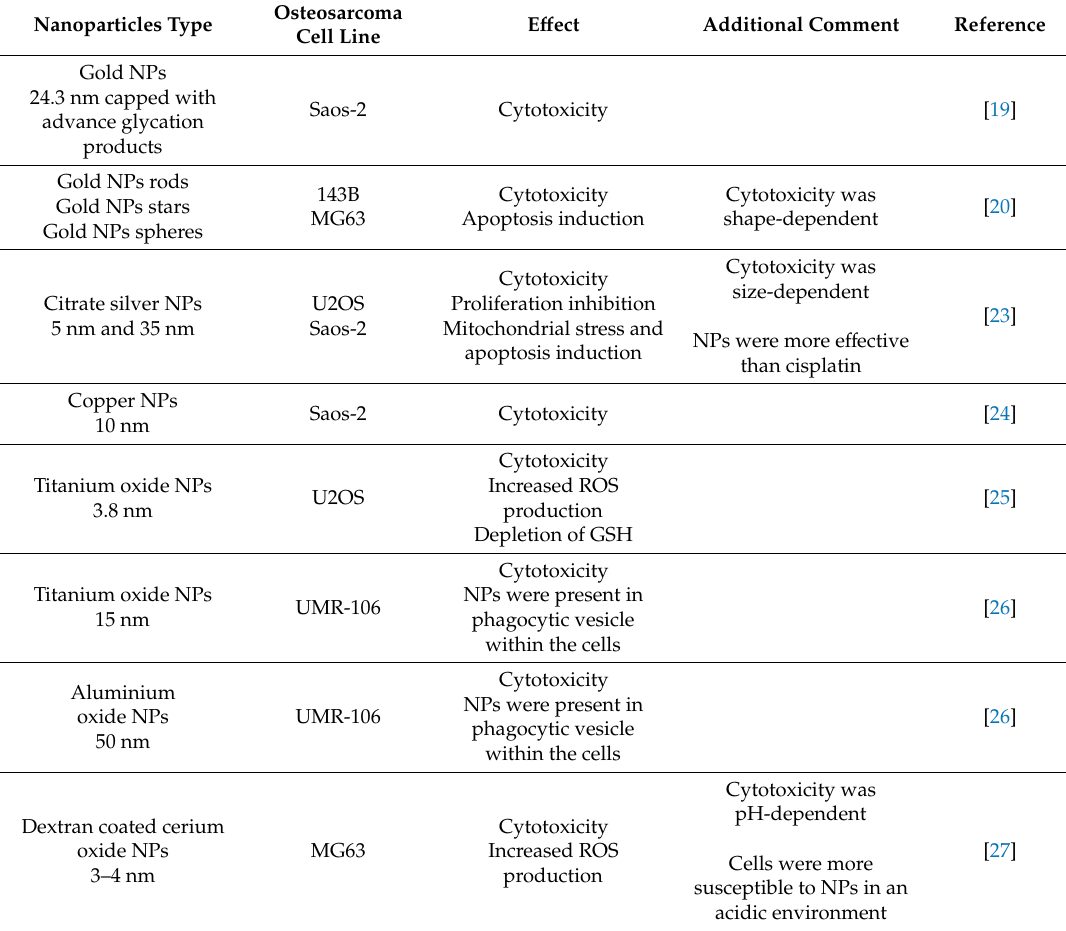
Table 1. Summary of nanoparticles (NPs) e ff ects in in vitro model of